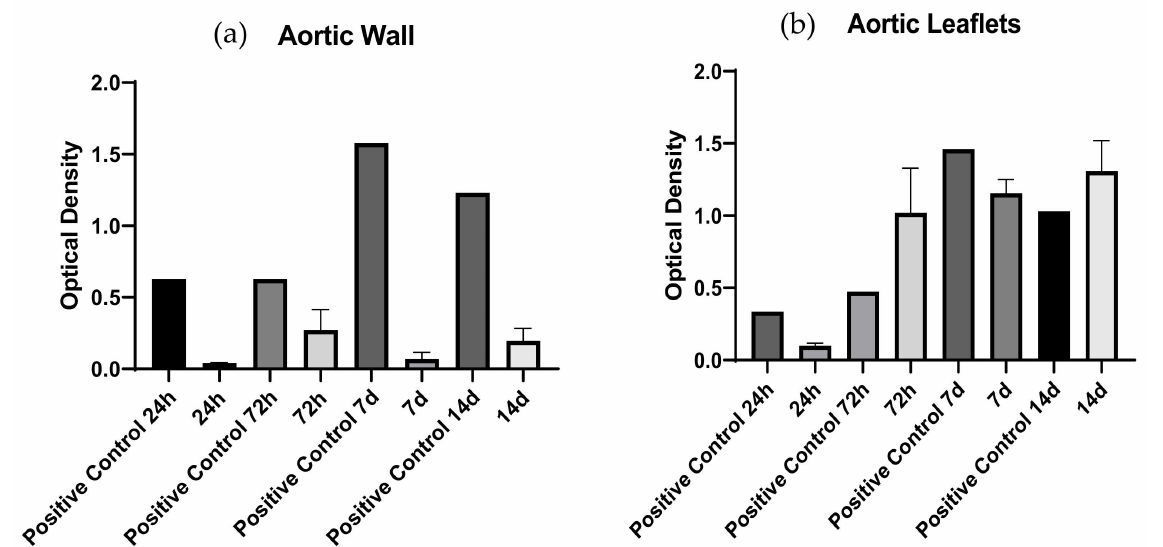
Figure 10. Analysis of metabolic activities of the cultured hMSC-BM cells at different time intervals was measured by WST-1 reduction assay. ( a ) aortic wall and ( b ) leaflets samples show significant differences in the proliferation capacity of the cells. Data were analyzed by one-way ANOVA ( p < 0.05). There was a significant difference between native and corresponding decellularized samples for the aortic